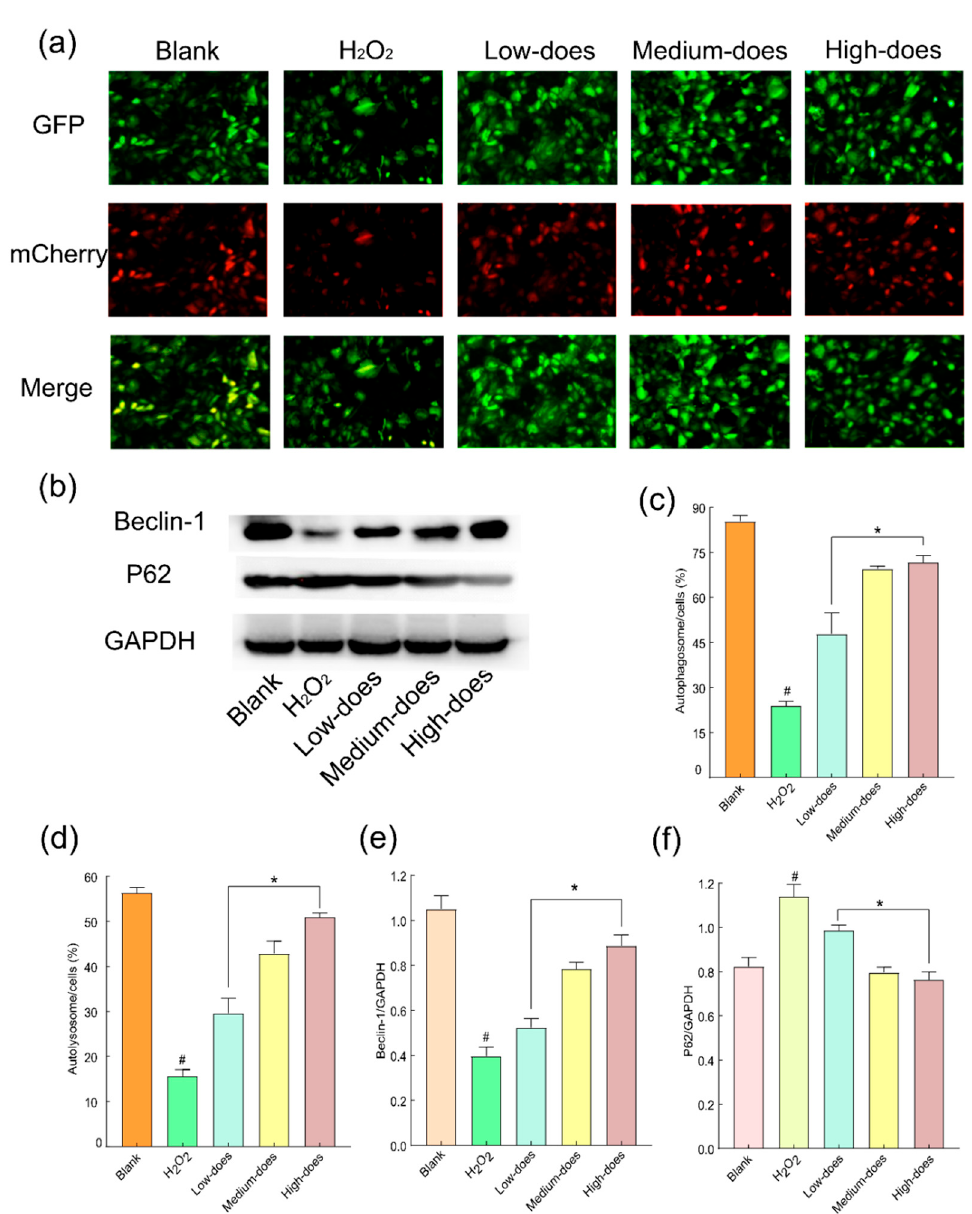
Figure 6. Effect of BMFs on the autophagy of rabbit lens epithelial cells after oxidative injury: ( a , c , d ) Effect of BMFs on autophagic flow after oxidative damage in rabbit lens epithelial cells; ( b , e , f ) Effect of BMFs on autophagy-related proteins after oxidative damage in rabbit lens epithelial cells. # Symbolizes compared with blank group, p < 0.01; * symbolizes compared with H 2 O 2 injury group, p < 0.01 .